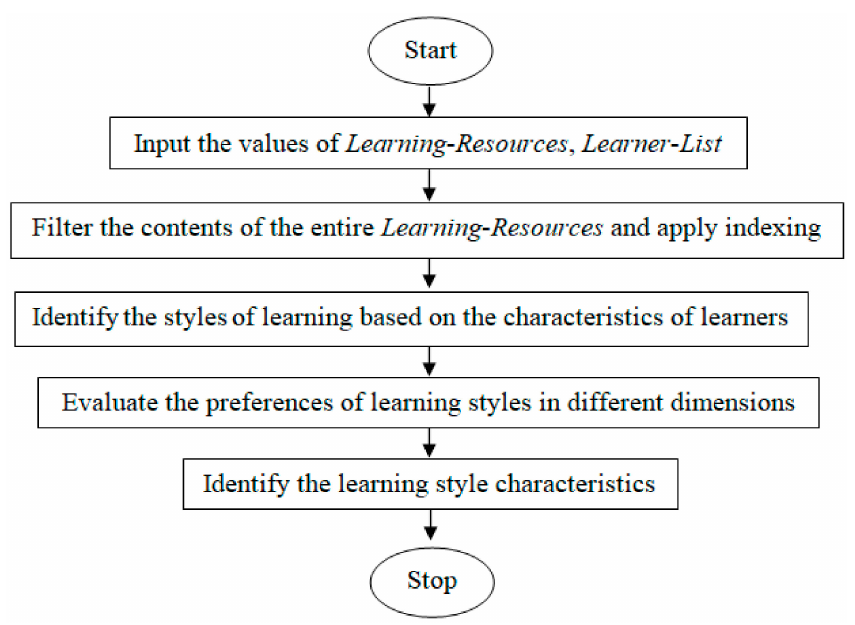
Figure 3. The overall flowchart of the proposed intelligent hybrid recommender.